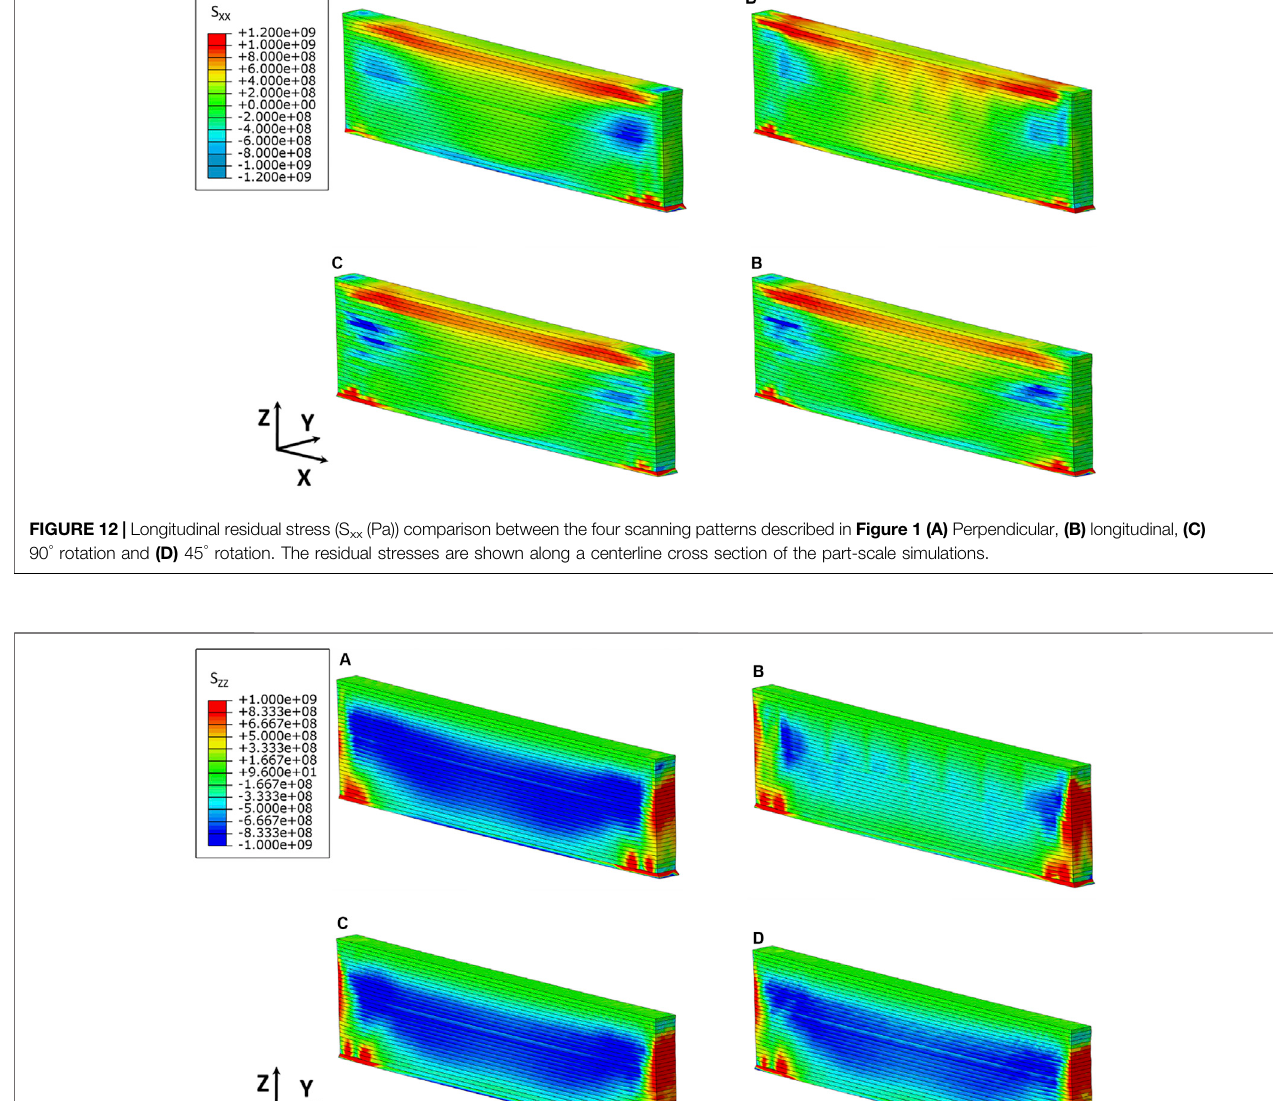
Frontiers in Materials |